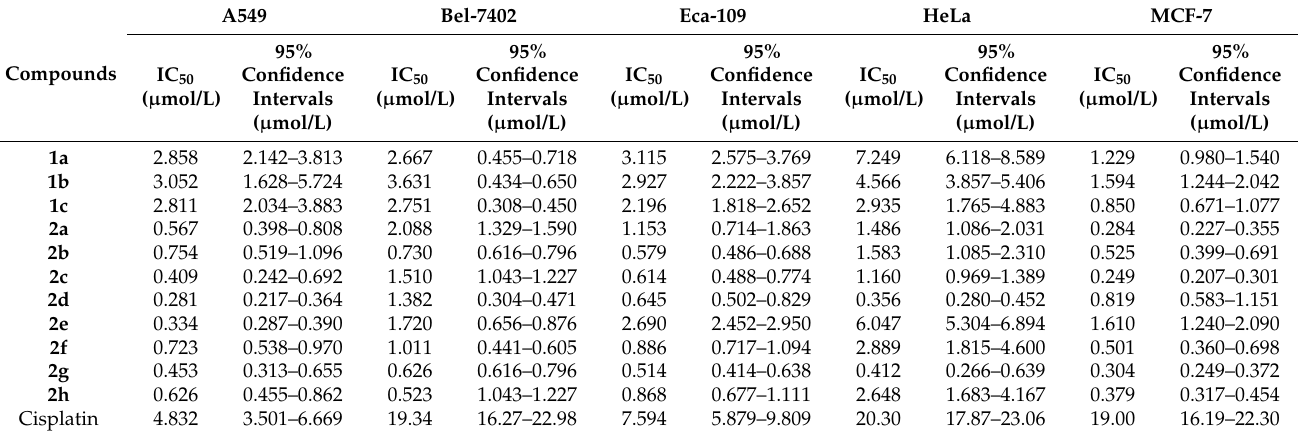
Table 1. IC 50 values ( μ M) from the dose-response assay of compounds 1a – 1c and 2a – 2h and the reference compound cisplatin in the A549, Bel-7402, Eca-109, HeLa and MCF-7 cell lines, after an incubation time of 48 h.